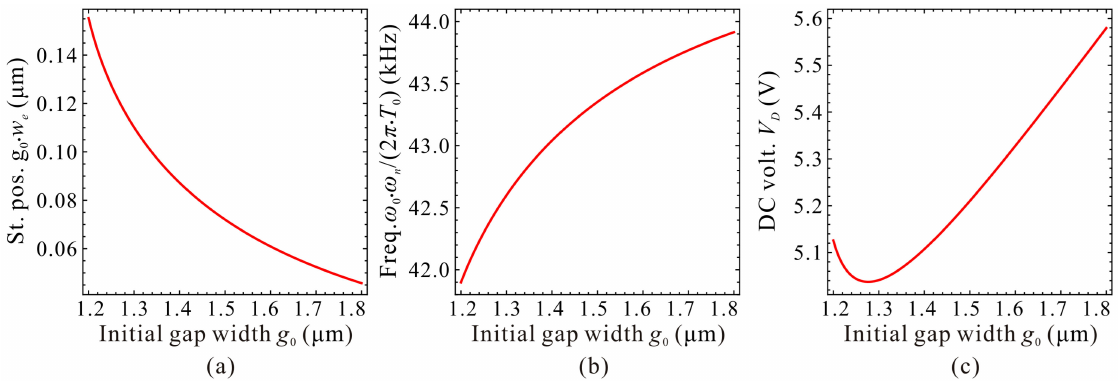
Figure 15. Qualitative property of the static position (St. pos.) ( a ), fundamental frequency (Freq.) ( b ) and DC voltage (DC volt.) ( c ) corresponding to point C 1 on frequency curve versus initial gap width.